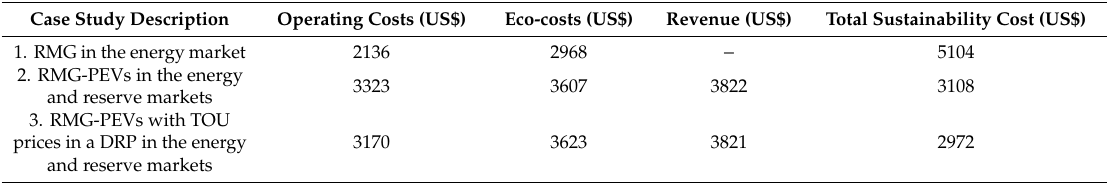
Table 5. Optimal costs obtained in the di ff erent case